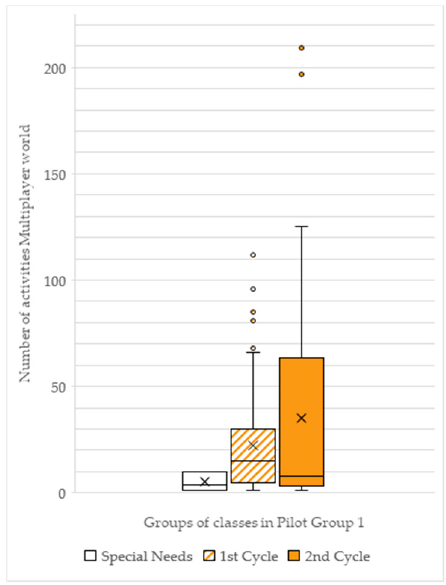
Figure 5. Descriptive statistic representation of significant results via one-way ANOVA analysis, showing the relationships between the number of activities played in the Multiplayer world per class